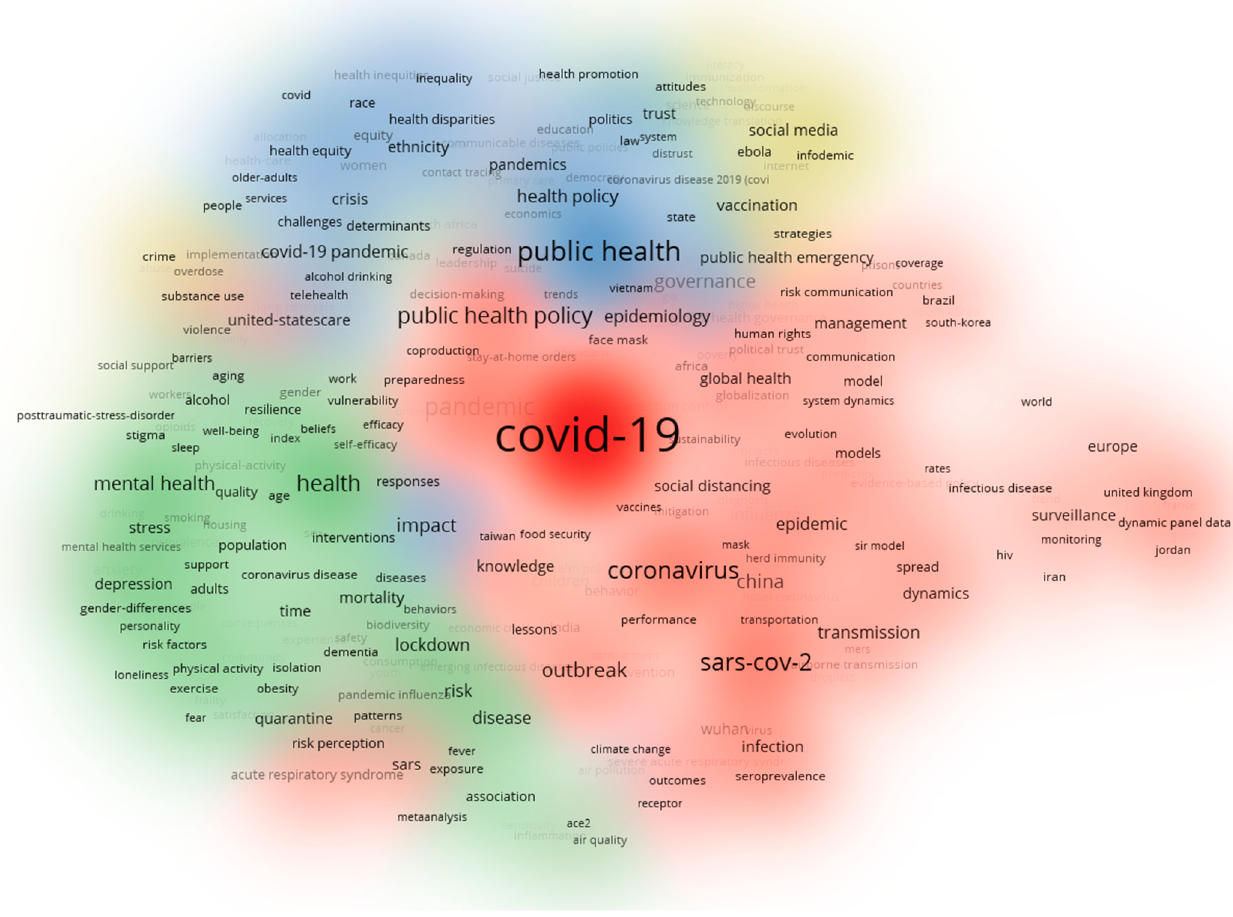
Figure 7. The cluster density visualization of the keywords’ co-occurrence network.